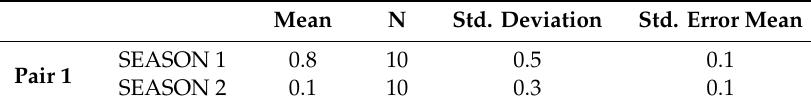
Table A13. Paired Samples Statistics.